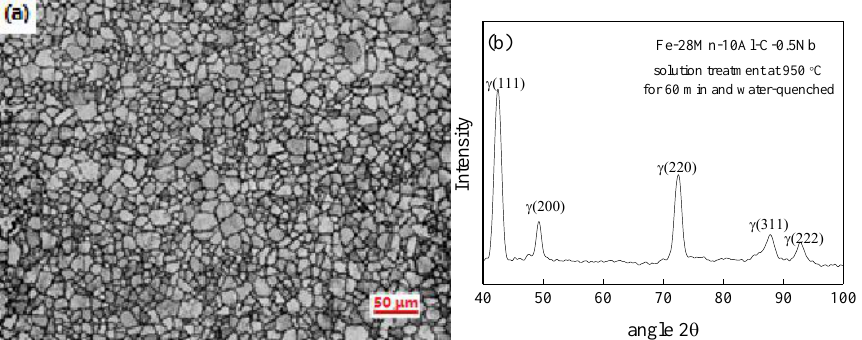
Figure 4. ( a ) Optical micrographs and ( b ) x-ray diffraction (XRD) profile of Fe–28Mn–10Al–C–0.5Nb steel after solution treatment at 950 °C followed by water-quenching.